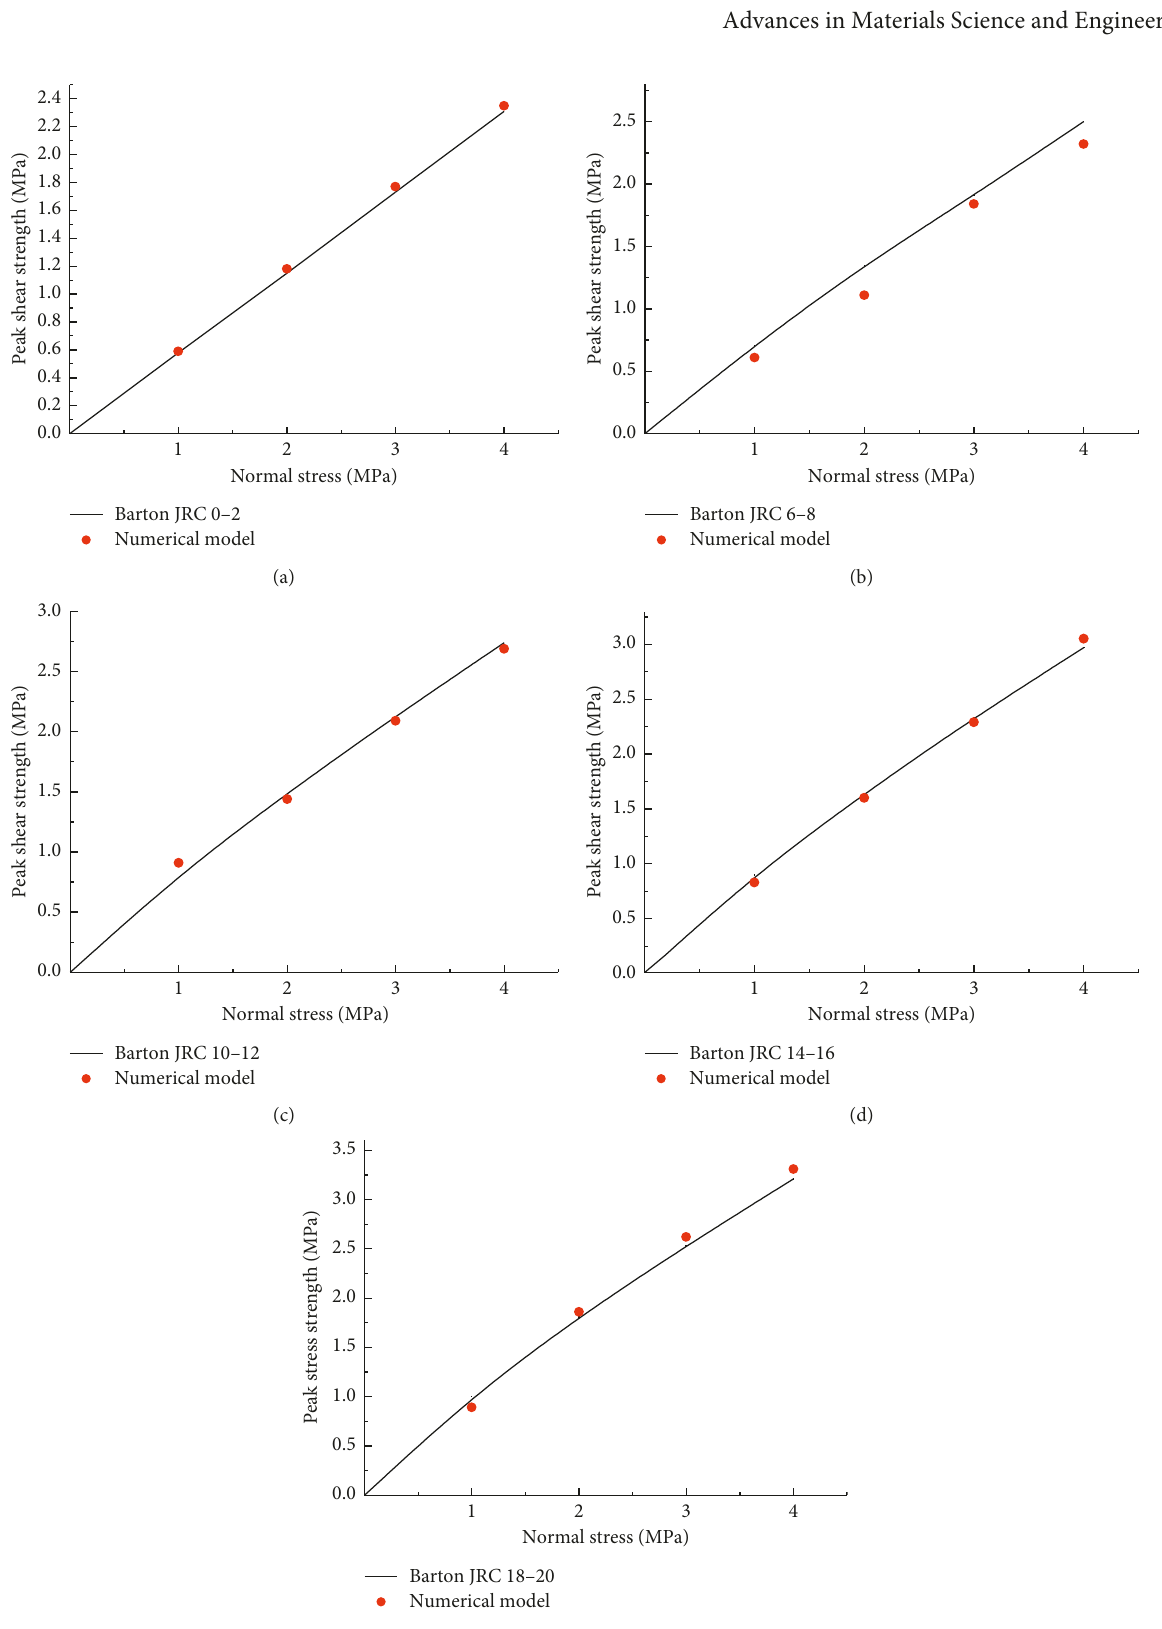
Figure 16: Comparison of the numerical and theoretical results for JRC